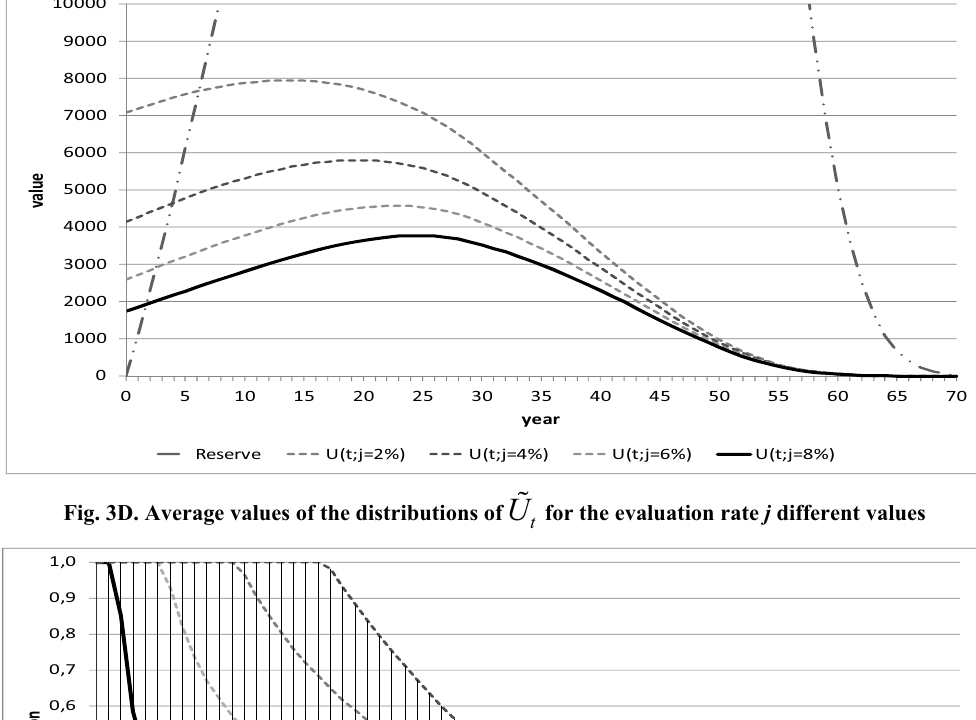
Fig. 3D. Average values of the distributions of